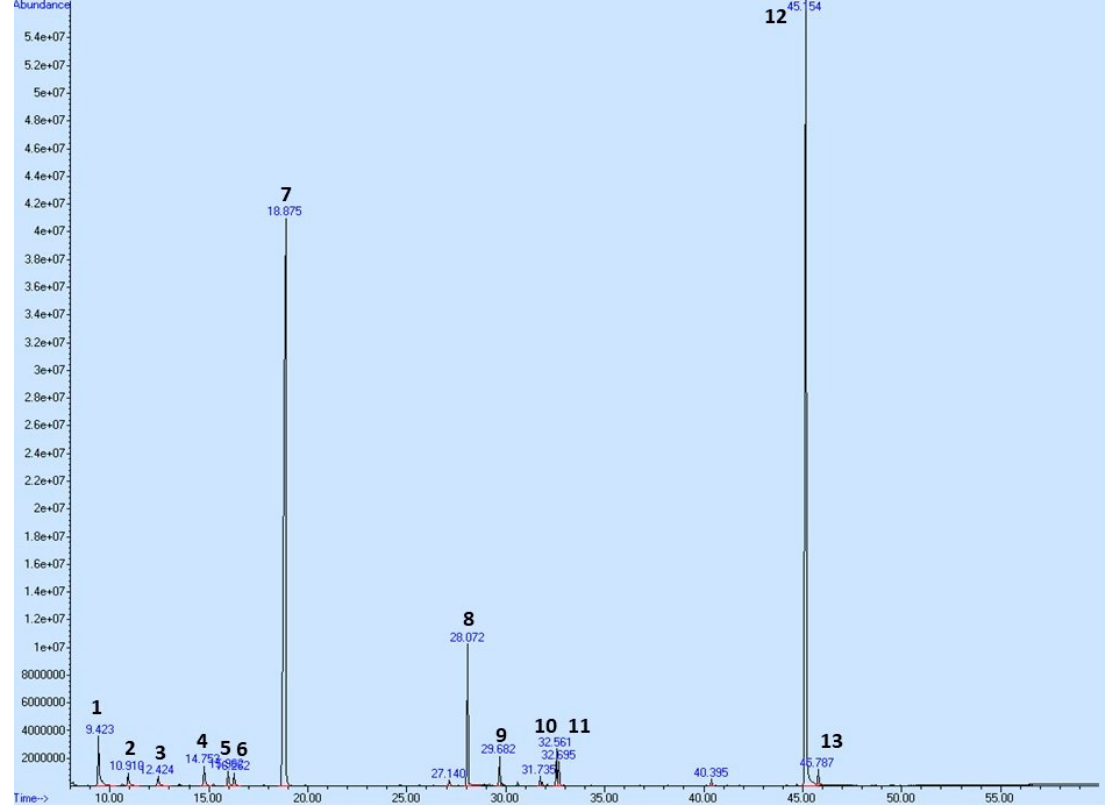
Figure 12. GC/MS chromatogram of EOT with the most abundant peaks. Numbering of peaks is explained in Table 7. Table 7. Relative abundance of major compounds of T. vulgaris essential oil.